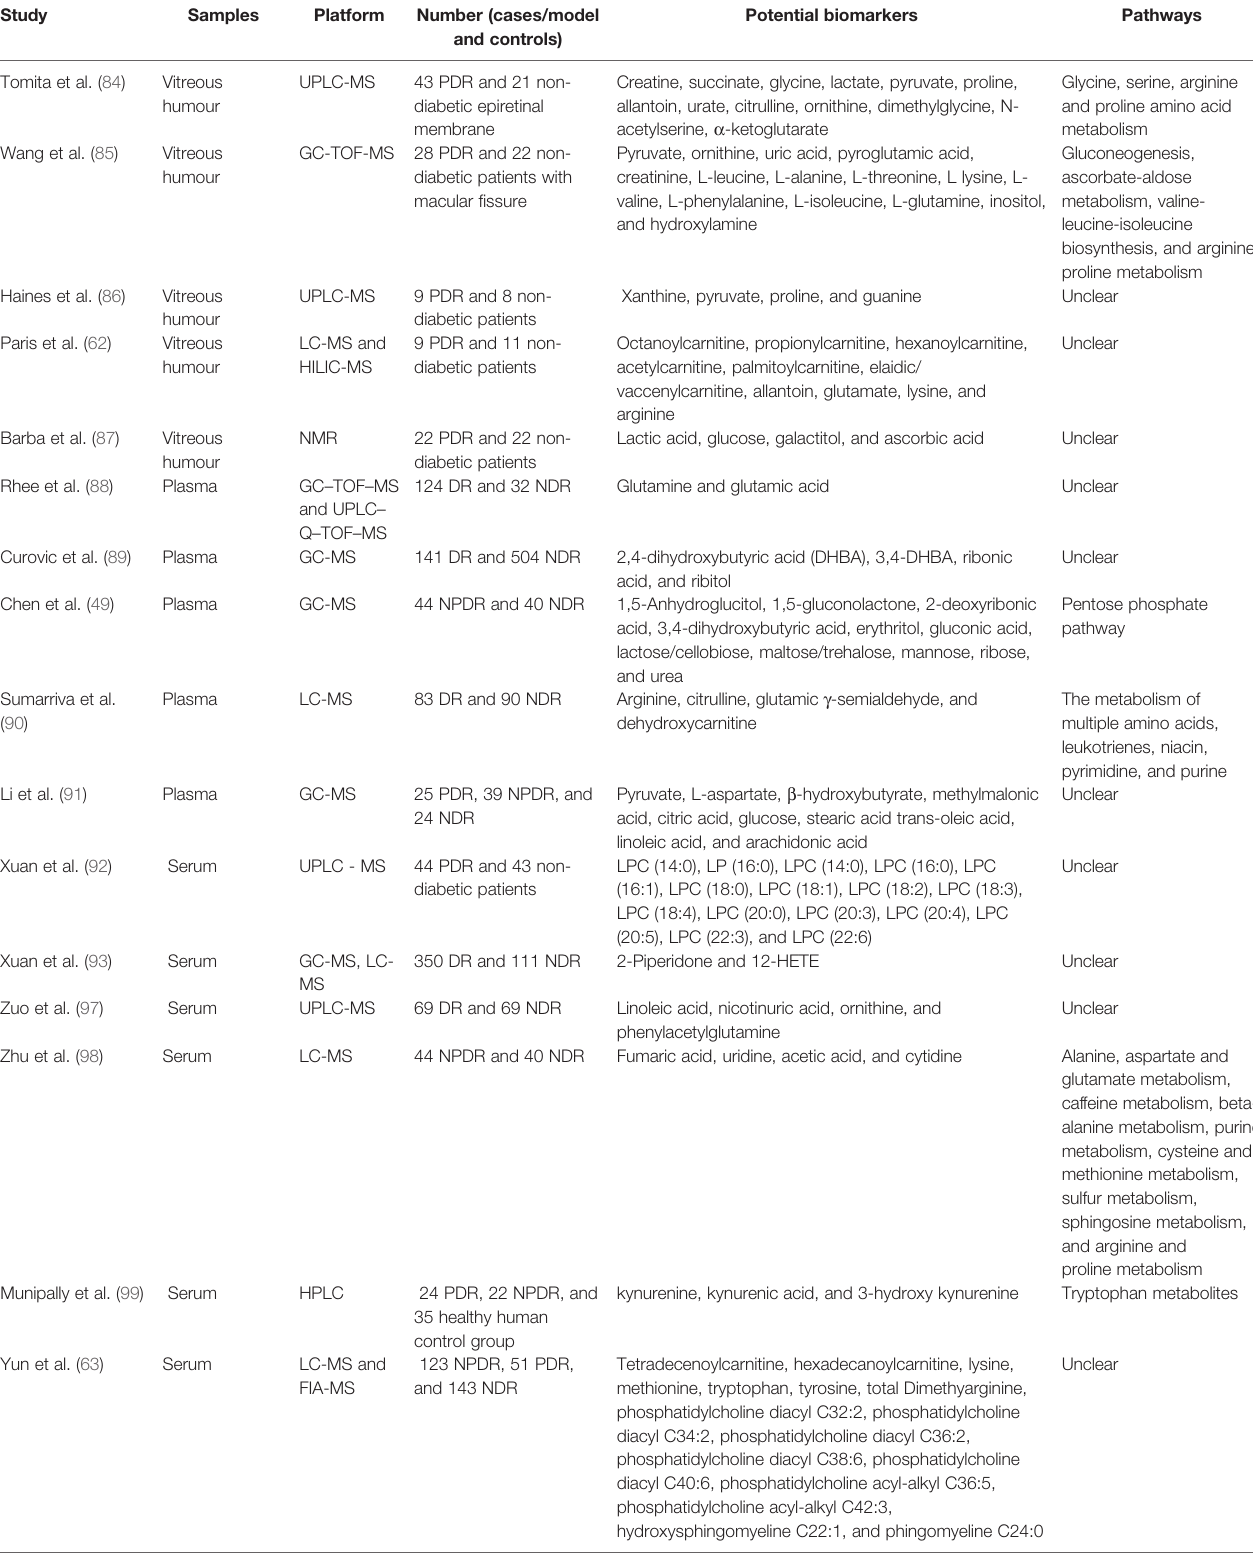
TABLE 1 | The information of diabetic retinopathy